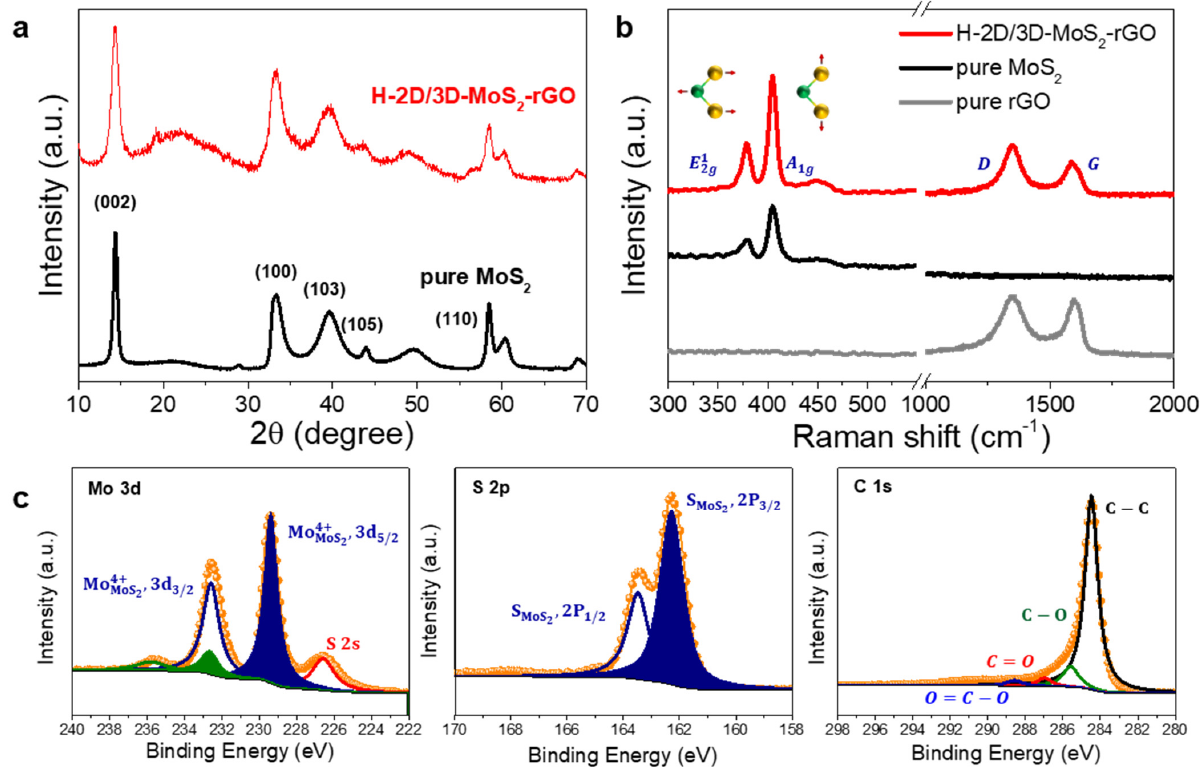
Figure 4. ( a ) XRD patterns for H-2D/3D-MoS 2 -rGO and pure MoS 2 . ( b ) Raman spectra for H-2D/3D-MoS 2 -rGO, pure MoS 2 , and pure rGO. ( c ) XPS spectra showing Mo 3d, S 2p, and C 1s in H-2D/3D-MoS 2 -rGO.